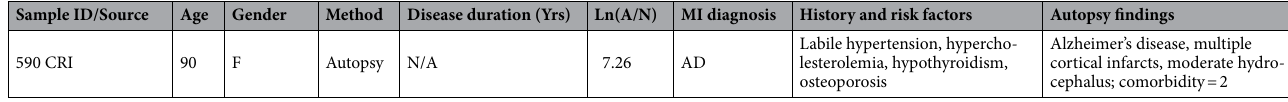
Table 1. Patient population: Autopsy-validated fibroblasts-based peripheral diagnosis of Alzheimer’s disease and the presence of co-morbidity (N = 25).